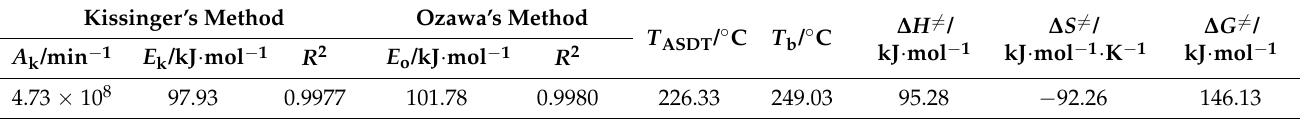
Table 3. Thermal decomposition kinetic parameters, thermodynamic parameters and thermal safety parameters of DFTNAN. Kissinger’s